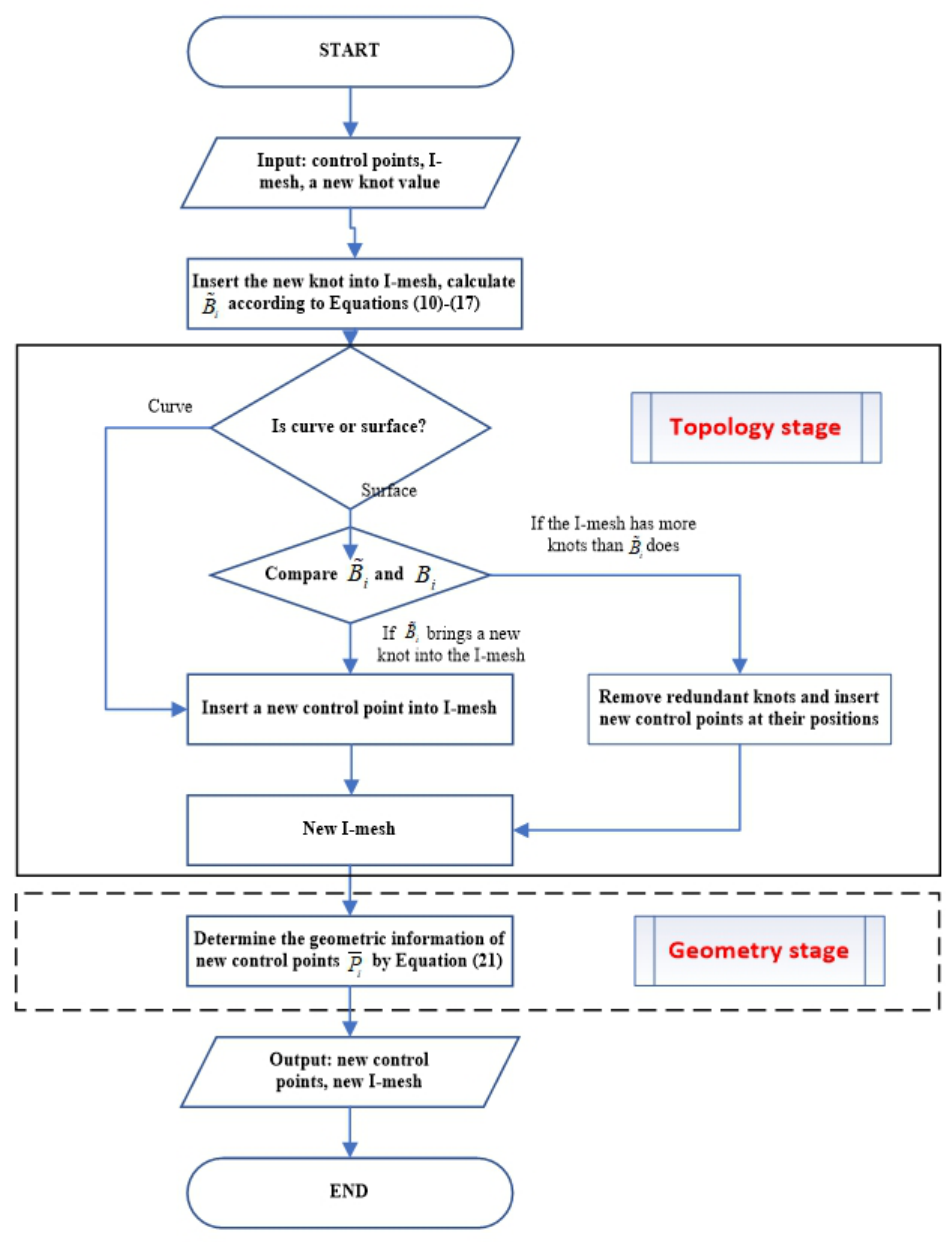
Figure 10. Local refinement of I-splines